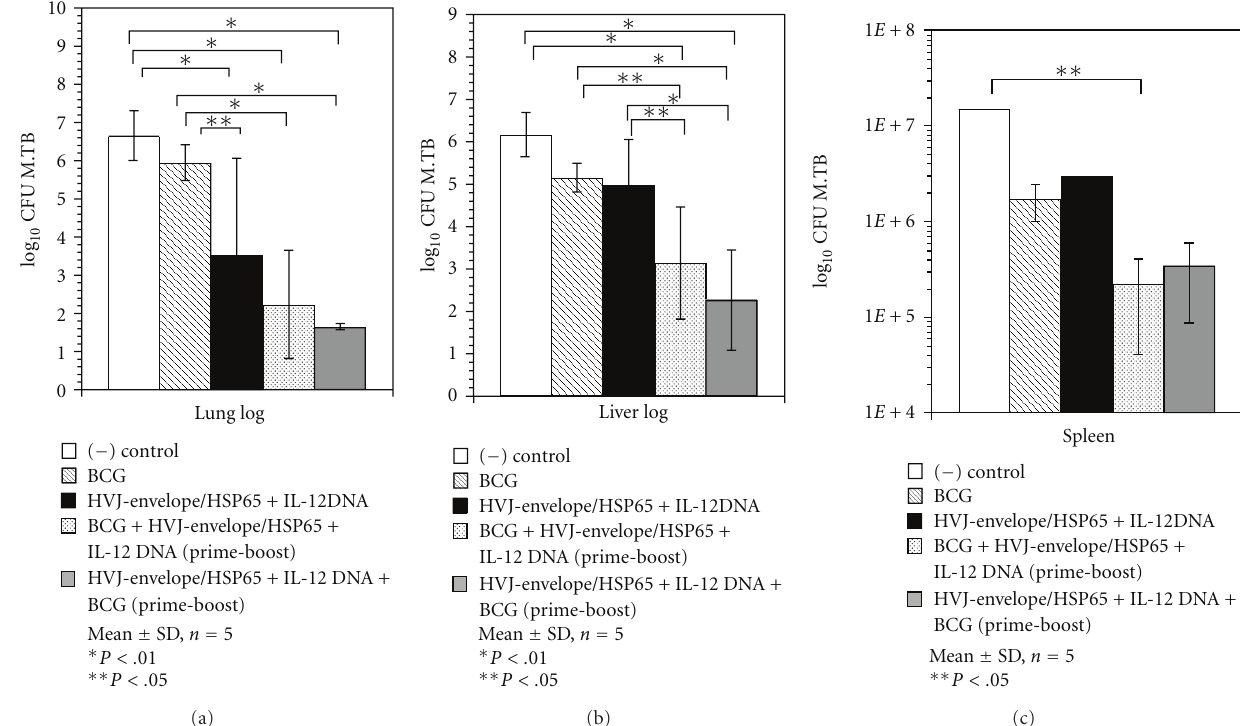
Figure 3: (a) Mouse protection studies using the prime-boost method. Groups of mice vaccinated with HVJ-envelope (HVJ-E) DNA and/or BCG were challenged by intravenous injection with M. tuberculosis H37Rv. Five weeks after challenge, protection was measured by enumerating the bacterial loads (CFU) in the lungs. Results are expressed as the mean log 10 ± S.D. of CFU. The statistical significance of di ff erences between individual groups in the CFU number was determined by Dunnett test ( n = 5); ∗ P < . 01 and ∗∗ P < . 05; the statistical significance of di ff erences ( P < . 01) of the G1 (naive) group compared to the G3 group (DNA/DNA/DNA), G4 group (BCG/DNA/DNA), or the G5 group (DNA/DNA/BCG). The statistical significance of di ff erences ( ∗∗ P < . 05) of the G2 group (BCG-alone group) compared to the G3 group (DNA/DNA/DNA), that of di ff erences ( P < . 01) of the G2 group compared to the G4 group (BCG/DNA/DNA), or the G5 group (DNA/DNA/BCG). (b) Mouse protection studies using the prime-boost method. Groups of mice vaccinated with HVJ-E DNA and/or BCG were challenged by intravenous injection with M. tuberculosis H37Rv. Five weeks after challenge, protection was measured by enumerating the bacterial loads (CFU) in the liver. Results are expressed as the mean log 10 ± S.D. of CFU. The statistical significance of di ff erences between individual groups in the CFU number was determined by Dunnett test ( n = 5), ∗ P < . 01; the statistical significance of di ff erences ( P < . 01) of the G1 (naive) group compared to the G4 group (BCG/DNA/DNA), or the G5 group (DNA/DNA/BCG). The statistical significance of di ff erences ( P < . 05) of the G2 group (BCG-alone group) compared to the G4 group (BCG/DNA/DNA). The statistical significance of di ff erences( P < . 01) of the G2 group compared to the G5 group (DNA/DNA/BCG). The statistical significance of di ff erences ( P < . 05) of the G3 group (DNA/DNA/DNA) compared to G4 (BCG/DNA/DNA). That of di ff erences ( P < . 01) of the G3 group compared to the G5 group. (c) Mouse protection studies using the prime-boost method. Groups of mice vaccinated with HVJ-E DNA and/or BCG were challenged by intravenous injection with M. tuberculosis H37Rv. Five weeks after challenge, protection was measured by enumerating the bacterial loads (CFU) in the spleen. Results are expressed as the mean log 10 ± S.D. of CFU. The statistical significance of di ff erences between individual groups in the number of CFU was determined by Dunnett test ( n = 5); ∗∗ P < . 05; the statistical significance of di ff erences ( P < . 05) of the G1 (naive) group compared to the G4 group